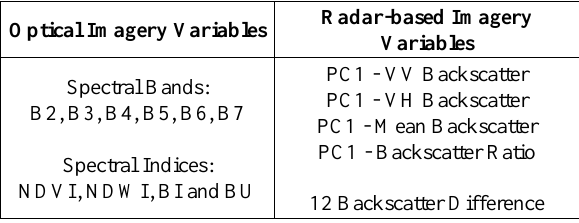
Table 1. Variables for reduced stacked image